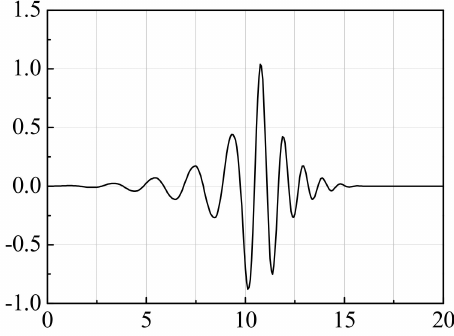
Figure 4. Fej é r–Korovkin wavelet with a length 22 filter.